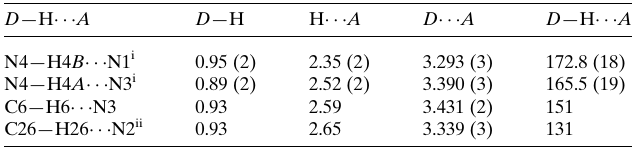
Table 1 Hydrogen-bond geometry (A˚ , (cid:3) ).